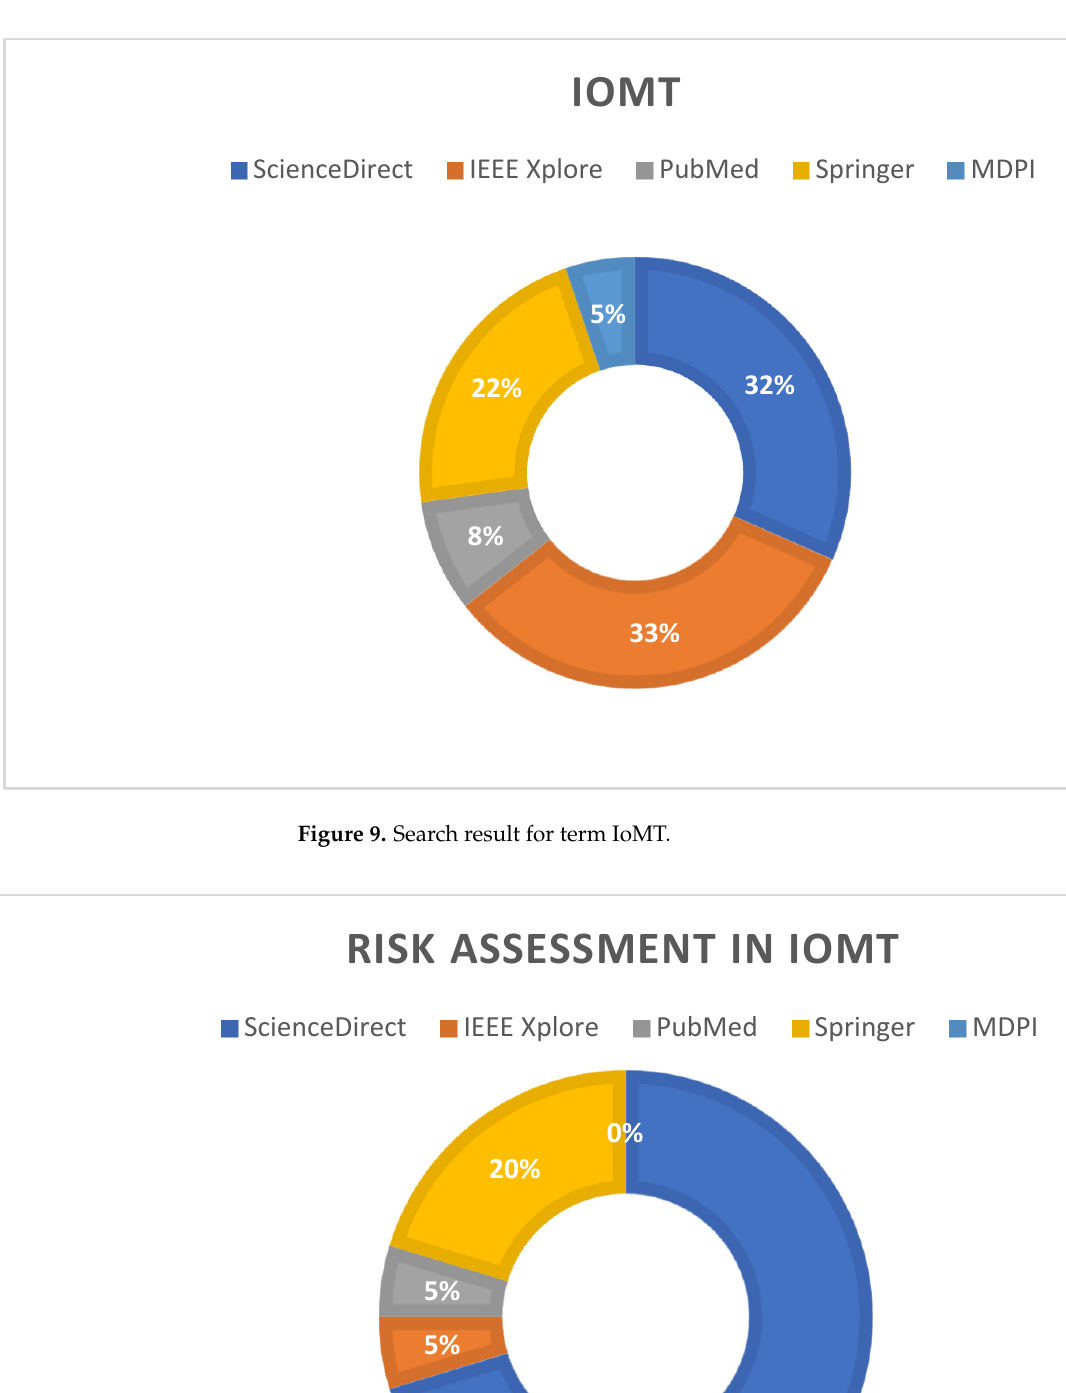
Figure 10. Search result for term Risk Assessment of IoMT devices.